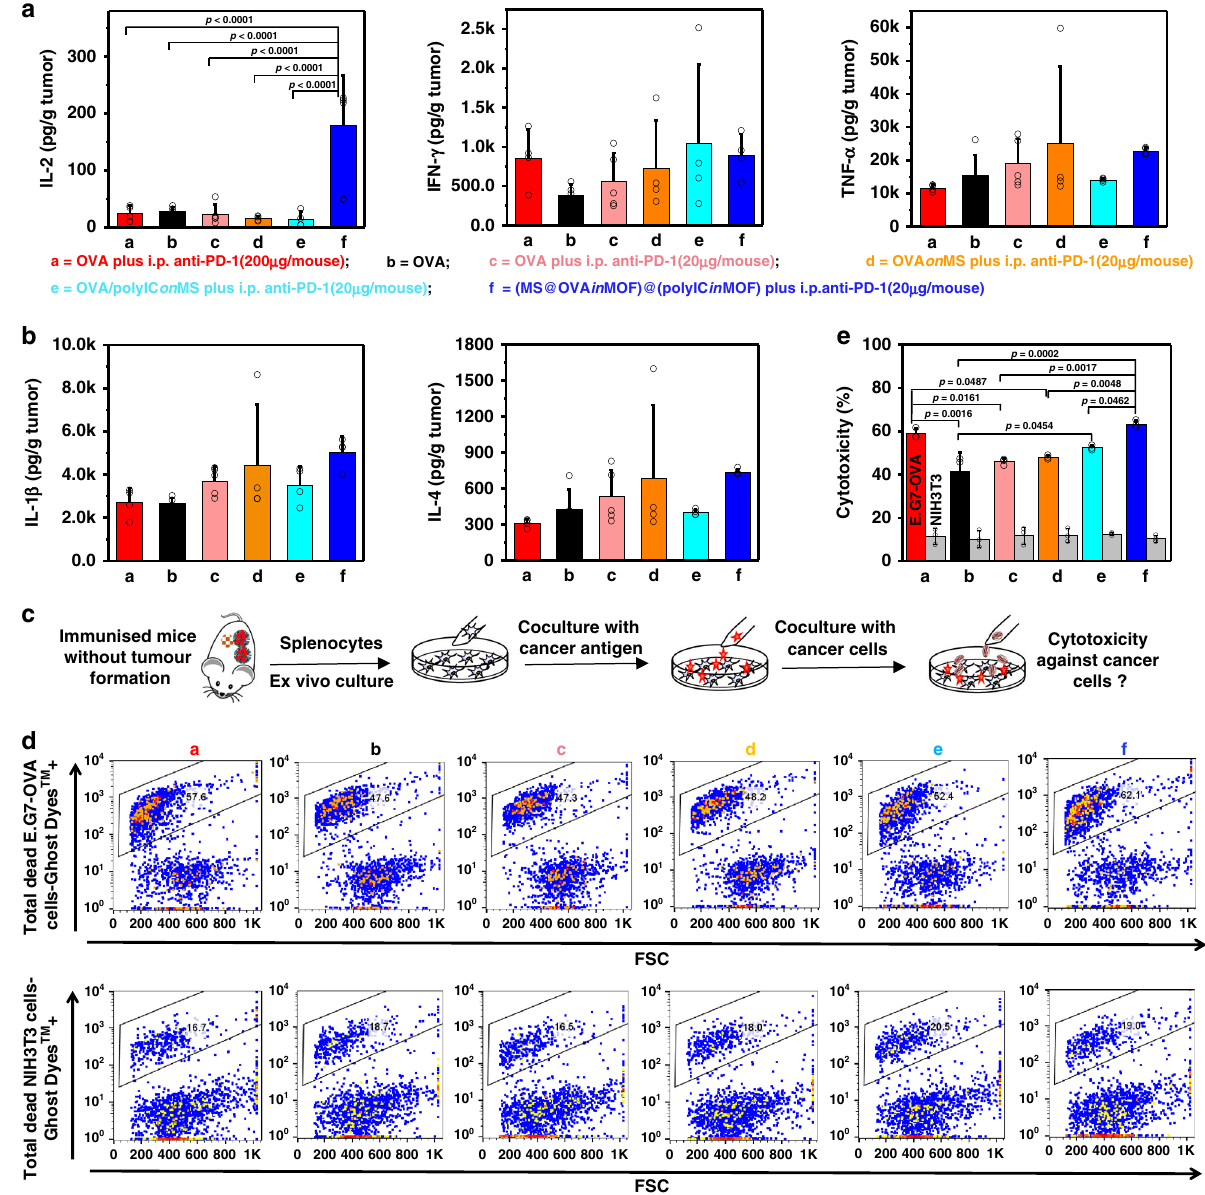
Fig. 6 Cytokines secretion in tumour sites and OVA-speci fi c cytotoxic CD8 + T-cell killing. a, b Cytokines in tumour at the endpoint ( a, d, e, f , n = 4 independent animals; b, c, n = 5 independent animals; one-way ANOVA followed by Tukey ’ s multiple comparisons post hoc test; IL-2, p < 0.0001). c A schematic representation of antigen-speci fi c cytotoxic T lymphocyte assay. The splenocytes were obtained from mice at the endpoint and cocultured with CFSE - stained live E.G7-OVA cancer cells or healthy NIH3T3 cells at the ratio of E/T = 10 and the speci fi city of cytotoxic CD8 + T cells against OVA were analysed using Ghost Dye ™ Violet 450 staining and fl ow cytometry. d Representative fl ow cytometry plots of the splenocytes derived from different mice against E.G7-OVA cancer cells or healthy NIH3T3 cells. e Cytotoxicity of the splenocytes derived from different mice against E.G7-OVA cancer cells or healthy NIH3T3 cells ( n = 3 independent samples, one-way ANOVA followed by Tukey ’ s multiple comparisons post hoc test; E.G7-OVA, p = 0.0002). All data ( a, b, e ) are presented as mean +